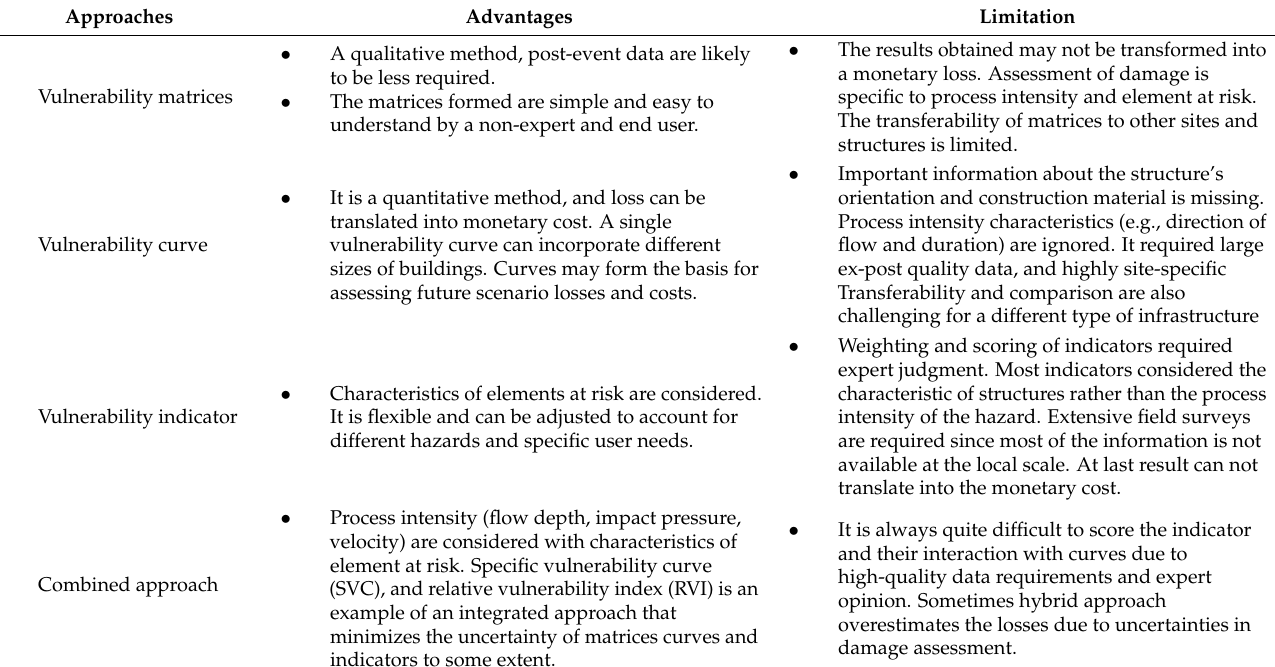
Table 2. Summary of the vulnerability